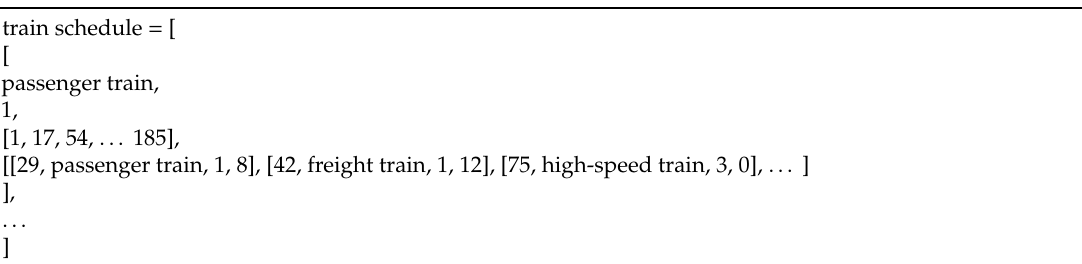
Table 4. Pseudocode for train schedule and scheduled waiting time.